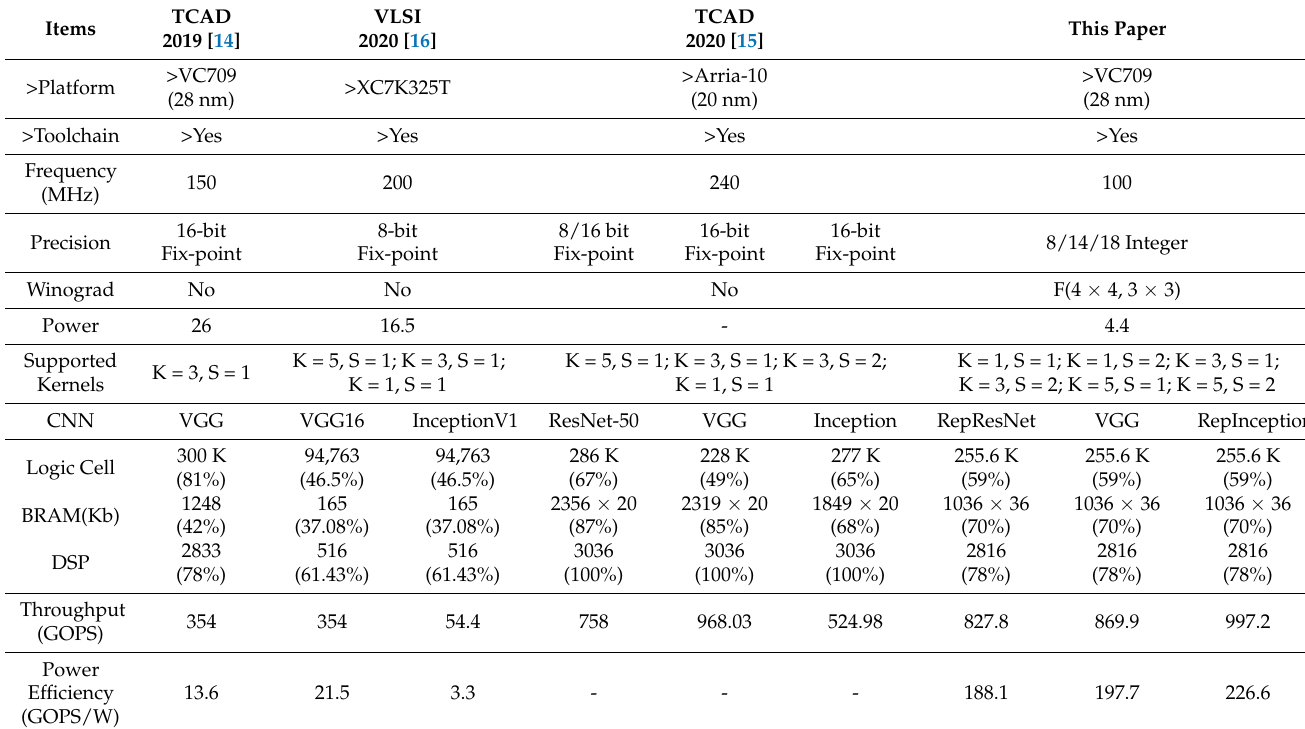
Table 4. Comparison between FPGA-based CNN accelerator with